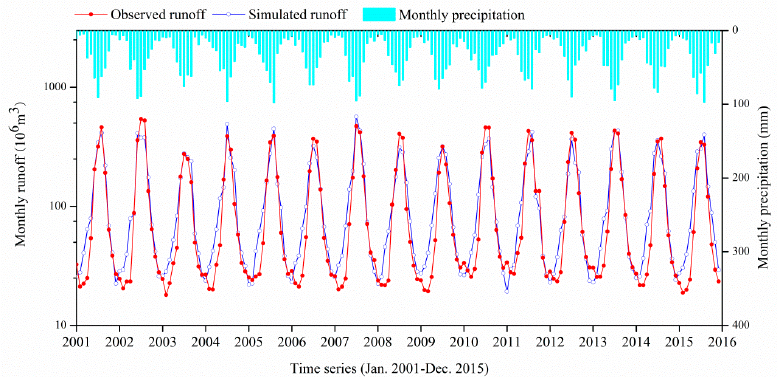
Figure 5. Mean monthly runoff in log-scale and precipitation during the calibration (2001–2010) and validation (2011–2015) period.